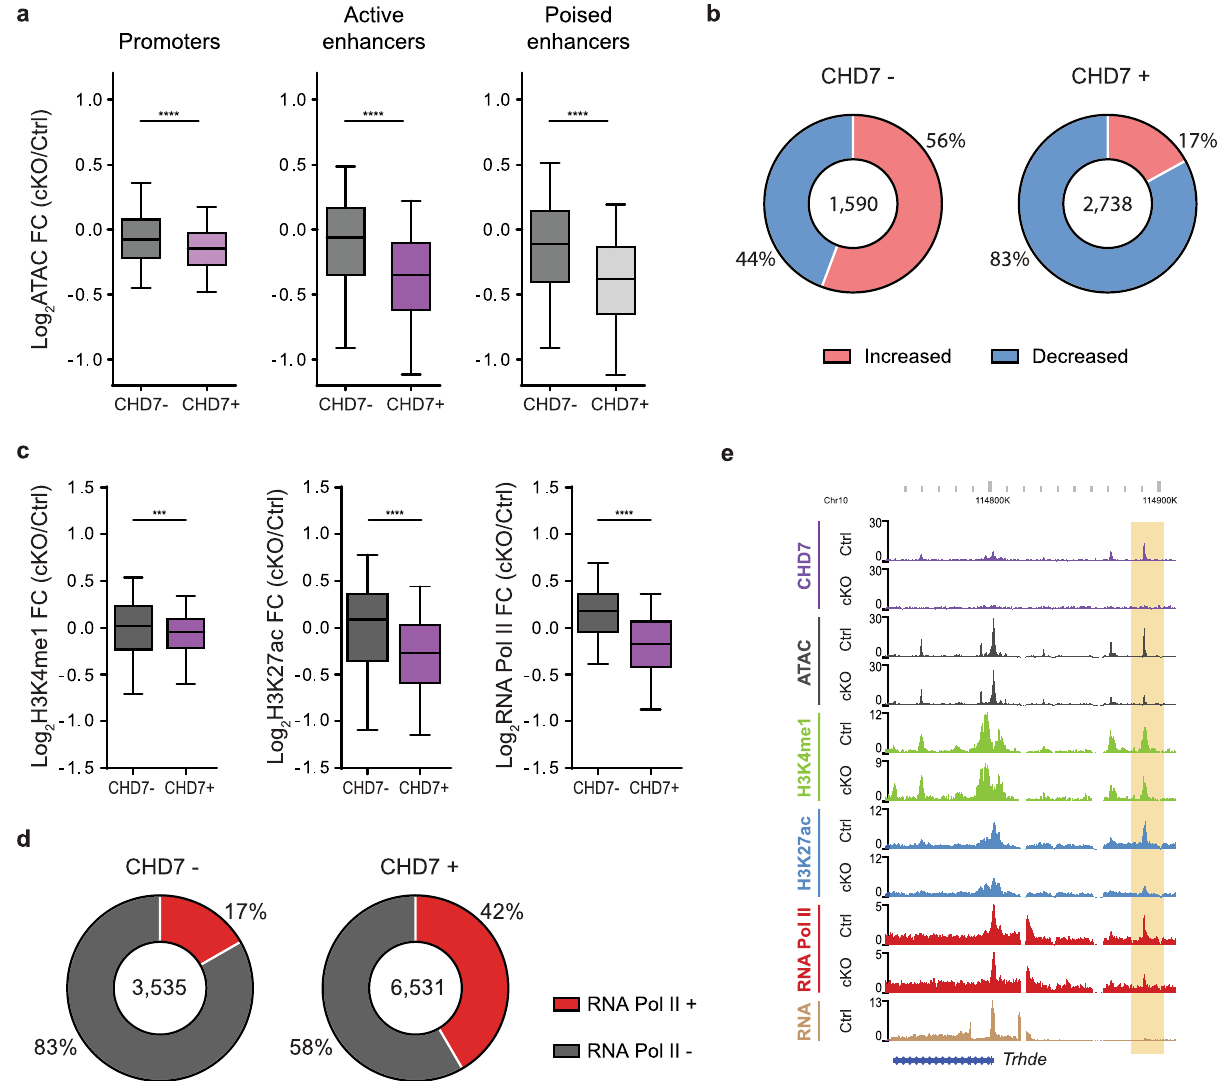
Fig. 2 CHD7 regulates chromatin accessibility and activity state at enhancers. a Box-whisker plots showing the median, 1st quartile, 3rd quartile, and whiskers displaying the 5th and 95th percentiles of promoters ( n = 11,398, n = 5238), active enhancers ( n = 3535, n = 6531), and poised enhancers ( n = 25,231, n = 8039) representing median and distribution of the log2 fold-change of ATAC-seq signal in CHD7 cKO over CHD7 control. CHD7 unoccupied, (CHD7 – ) left, and occupied, (CHD7 + ) right, enhancers are shown. **** p < 10 − 4 , unpaired two-sided t -test, Welch ’ s correction. b Pie chart representing proportion active enhancers that show signi fi cantly changed accessibility in the CHD7 cKO, which display either increased or reduced accessibility. c Box-whisker plots showing the median, 1st quartile, 3rd quartile, and whiskers displaying the 5th and 95th percentiles of active enhancers representing median and distribution of the log2 fold-change of H3K4me1 (left; n = 760, n = 2457), H3K27ac (middle; n = 1590, n = 2738), and RNApolII (right; n = 249, n = 1099) signal in CHD7 cKO over CHD7 control. *** p < 10 – 3 , **** p < 10 − 4 , unpaired two-sided t -test, Welch ’ s correction. d Pie chart representing proportion of CHD7 unoccupied (CHD7 − ; left) and occupied (CHD7 + ; right) active enhancers displaying RNApolII binding. e WashU Epigenome Browser view of a CHD7-bound active enhancer (highlighted) near the Trhde gene. ChIP-seq coverage for CHD7, H3K27ac, H3K4me1, RNApolII, as well as ATAC-seq and RNA-seq is